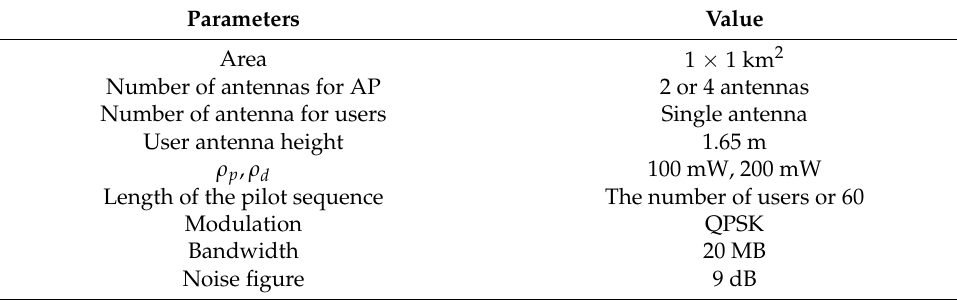
Table 2. Simulation Parameters and Schemes.